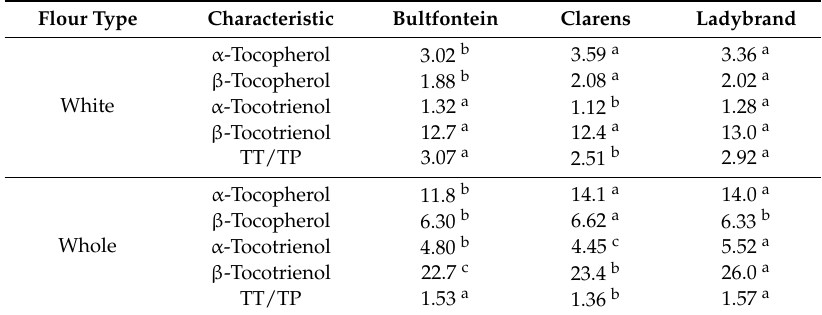
Table 4. Average content of each tocol compound (mg kg − 1 ) in three locations from white and whole